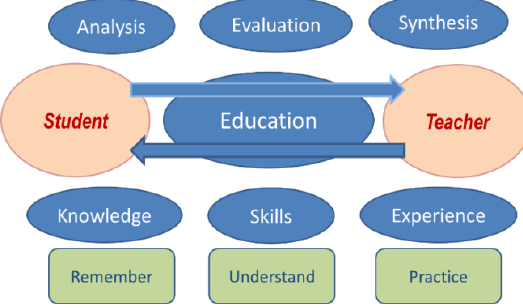
Fig. 1. A two-way process in which the student and the teacher